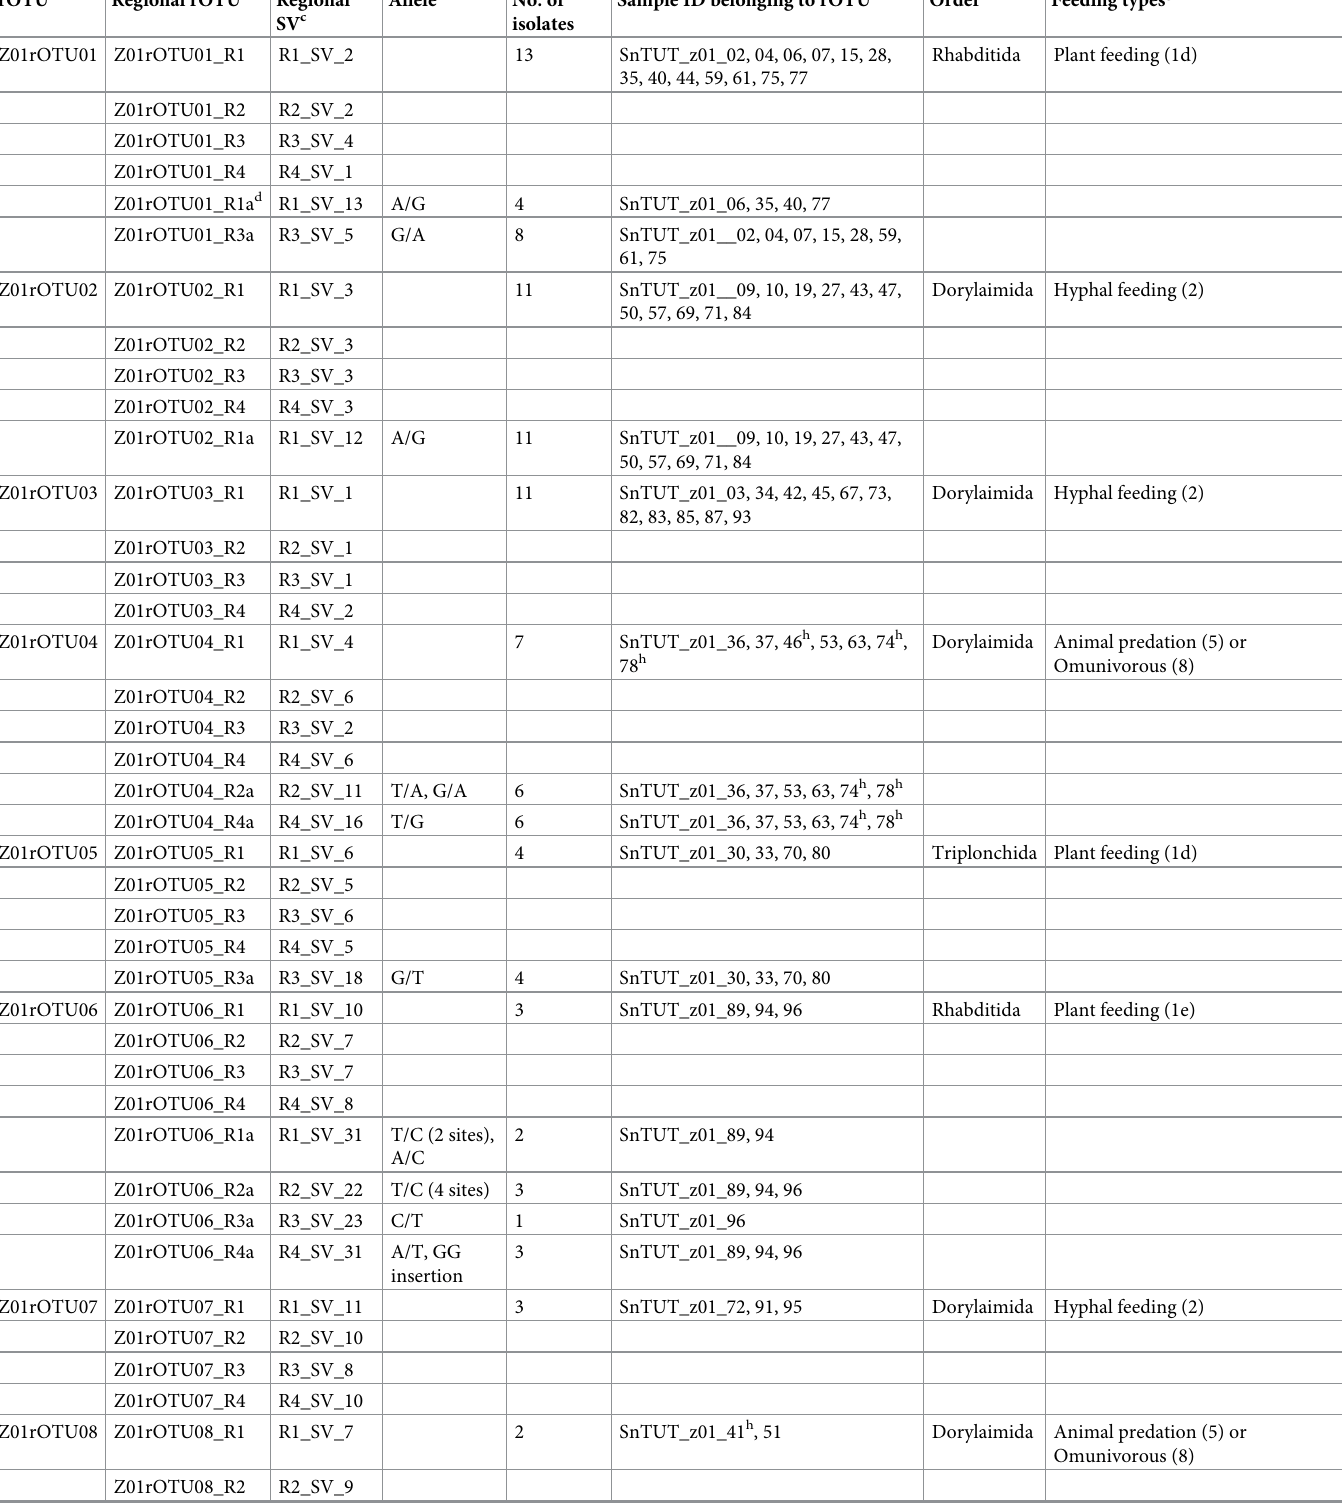
Table 3. Summary of nematode-derived rOTUs identified from deep amplicon sequencing in four SSU gene regions. Allele d No. of Sample ID belonging to rOTU e Order f Feeding types g rOTU a Regional rOTU b Regional SV c isolates Z01rOTU01 Z01rOTU01_R1 R1_SV_2 13 SnTUT_z01_02, 04, 06, 07, 15, 28, Rhabditida Plant feeding 35, 40, 44, 59, 61, 75, 77